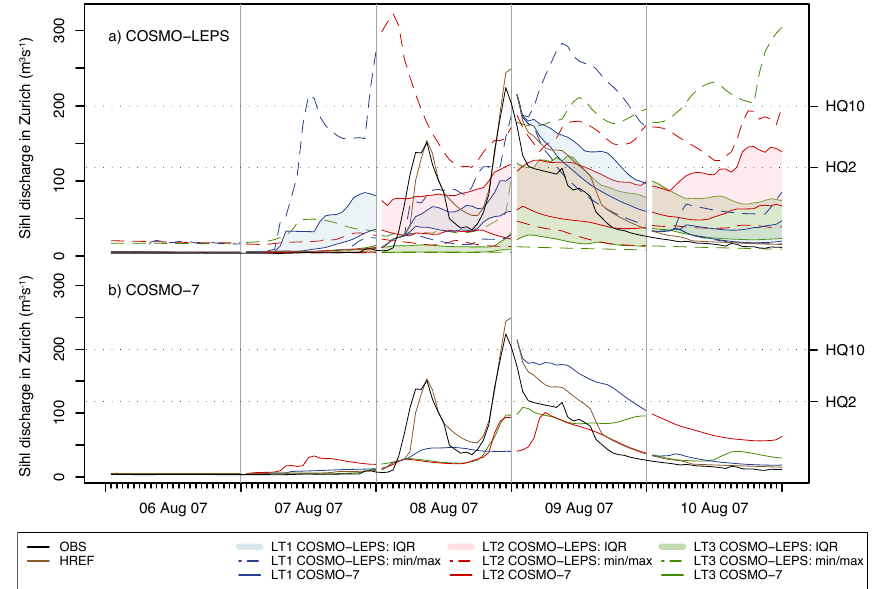
Fig. 8. Continuous persistence plots centred on the 8 August 2007 event depicting the discharge in Zurich. COSMO-LEPS-based (a) and COSMO-7-based forecasts (b) are shown for lead times of 1, 2 and 3 days (LT1, LT2 and LT3). The vertical grey lines indicate 00:00UTC. Discharges associated with return periods of 2 and 10 years are depicted by the horizontal dotted lines, HQ2 and HQ10, respectively.